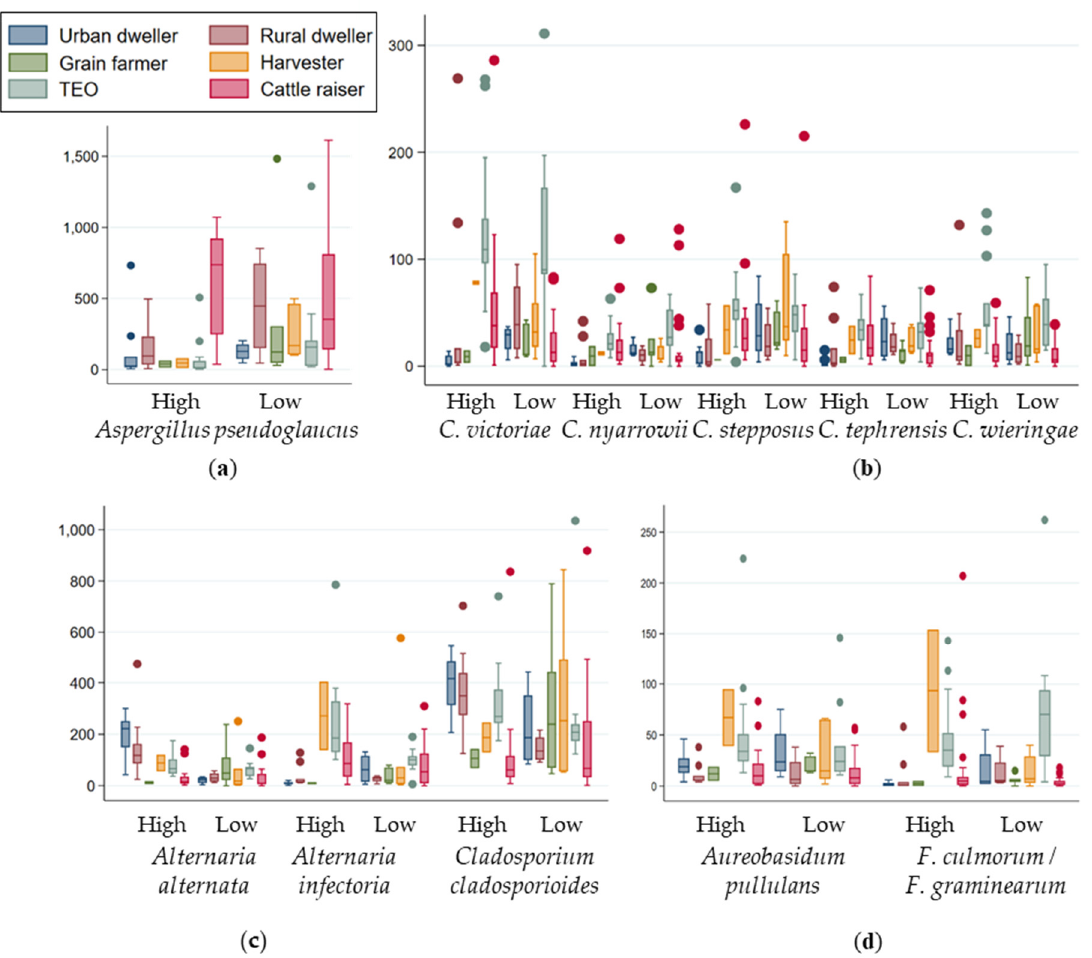
Figure 5. Examples of differences in exposure to fungal species of clinical importance among worker categories by exposure period, “High” indicates the high exposure period and “Low” the low exposure period: ( a ) Relative abundance of Aspergillus pseudoglaucus was much higher in cattle raisers during the period of high exposure; ( b ) relative abundance of five distinct Cryptococcus species; ( c ) relative abundance of Alternaria infectoria was higher at working places where wheat was handled, although that of Alternaria alternata and Cladosporium cladosporioides was higher in rural and urban dwellings; ( d ) relative abundance of Aureobasidum pullulans and Fusarium culmorum/F. graminearum was higher in harvesters’ environment during the high exposure period.